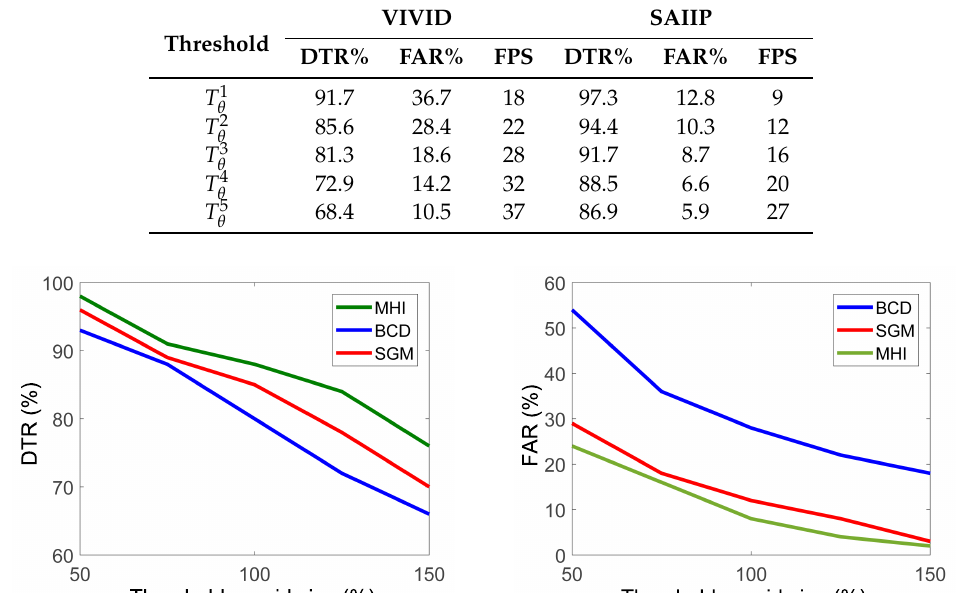
. DTR, Detection Ratio; θ